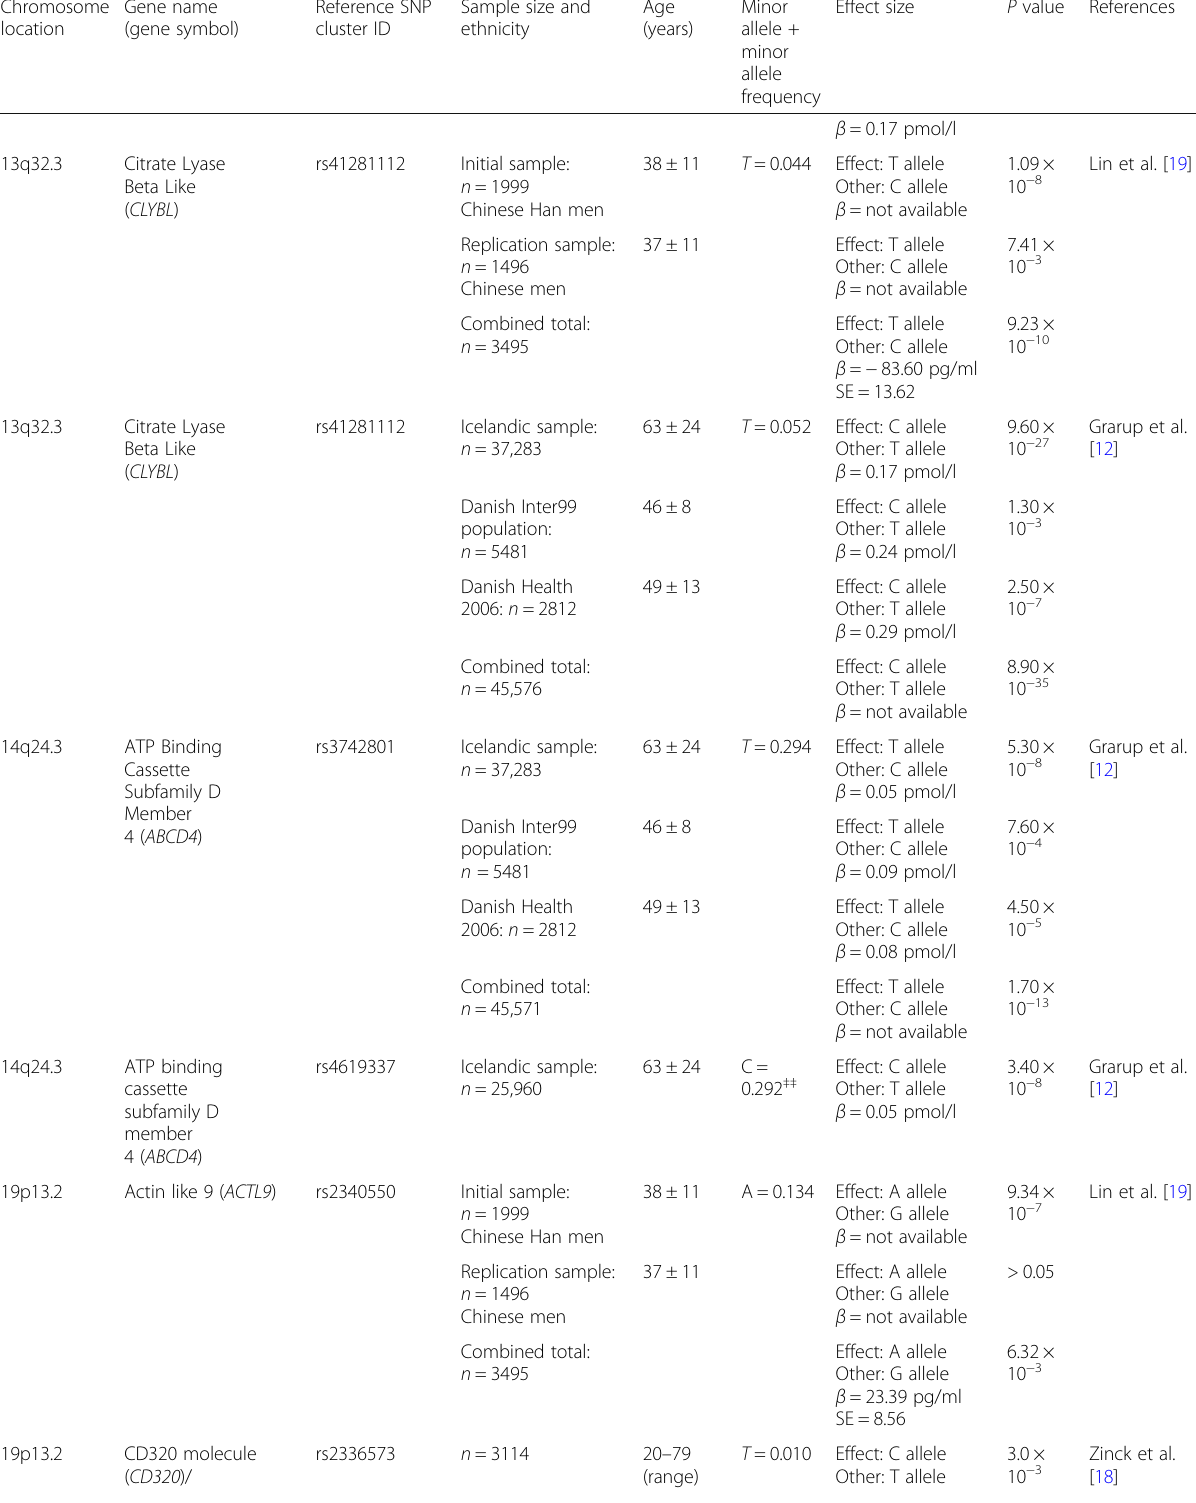
Table 1 Genome-wide association studies showing the association of SNPs with vitamin B12 concentrations. Genome-wide association studies testing the association between SNPs and vitamin B12 concentrations. The chromosome location, gene name, reference SNP cluster ID, sample size and ethnicity, mean age, observed frequency of the minor allele in the population, effect size and P value are shown in the table. The order of SNPs reflects the order of the chromosome location